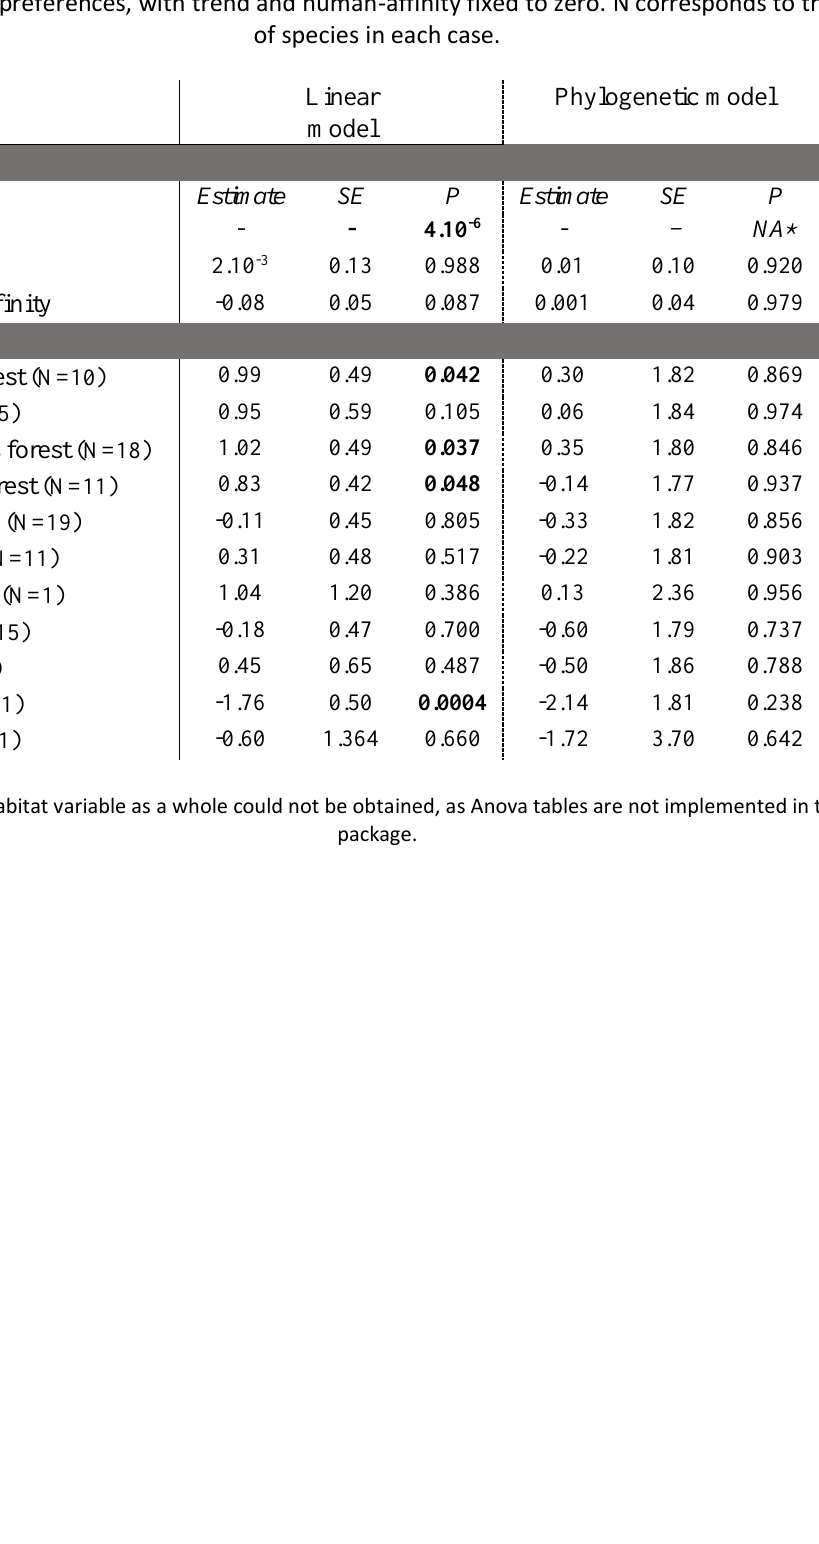
Table 1: Model summaries regarding the estimated effect of Protected Areas on species within forest routes (PAE For ): linear model and phylogenetic linear model with Brownian motion model. The top part gives estimates and P-values for all covariates, the bottom part gives estimates and P-values for all species’ habitat preferences, with trend and human -affinity fixed to zero. N corresponds to the